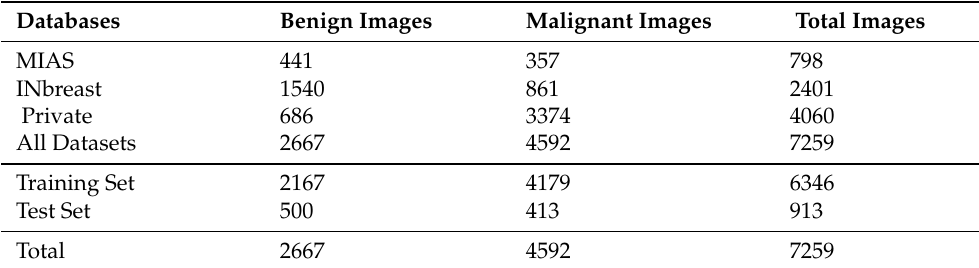
Table 3. The experimental dataset’s